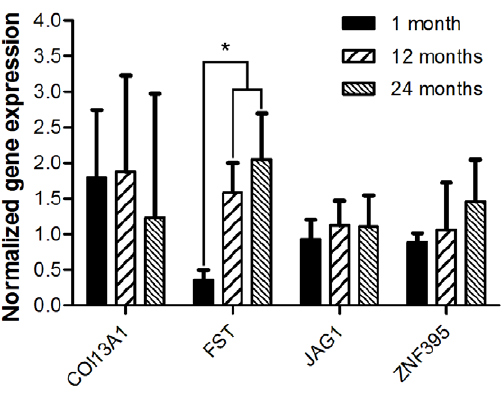
Figure 5. Validation of gene-expression in rat MSCs. To assess if age-related gene-expression was similar inter-species, MSCs were isolated from 1, 12 and 24 month old rats. The correlation between the expression of follistatin and age could be verified in rat MSCs, suggesting this is possibly a marker for several species. For the other three genes no correlation was